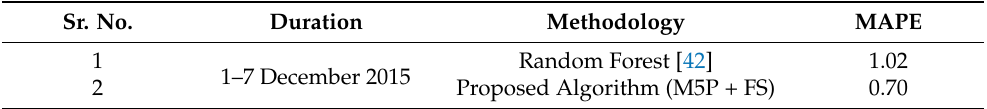
Table 8. Validation of proposed method.